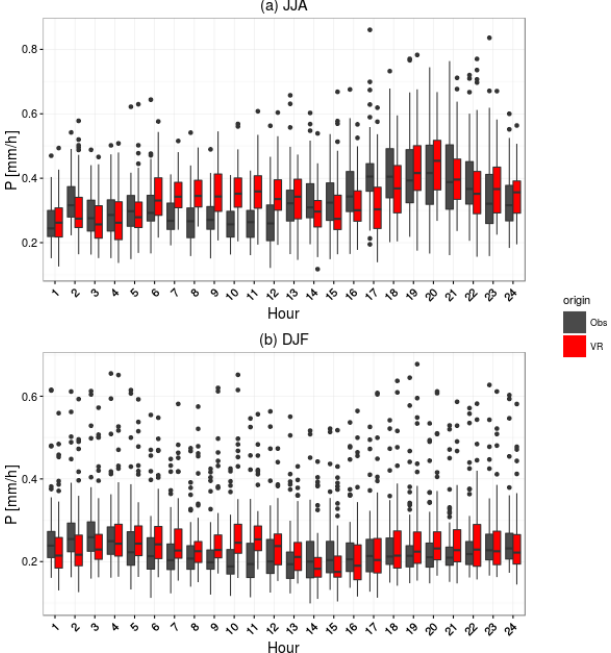
Figure 6. (a) Daily precipitation distribution on a monthly basis as observed (black) and simulated (red). The gray and red lines indicate the monthly mean precipitation. (b) Maximum daily pre- cipitation for the given months for the 71 DWD stations and the corresponding simulation. Box sizes as explained in the caption of Fig.